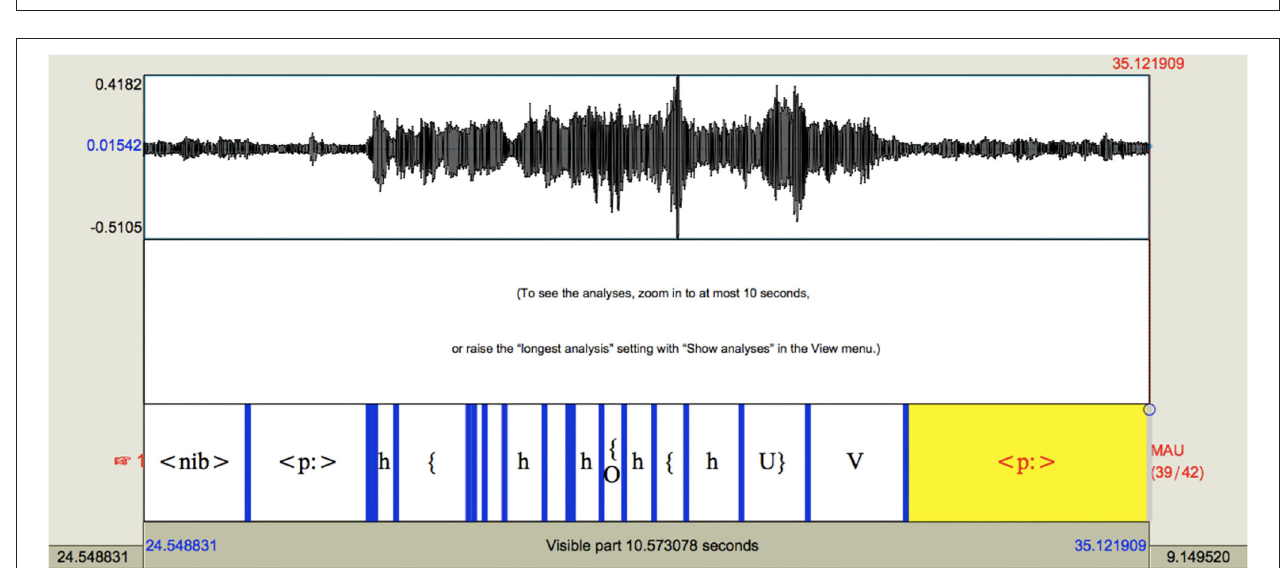
FIGURE 1 | Example 1 of system output with the poor quality recording using WEBMINNI, ASR.